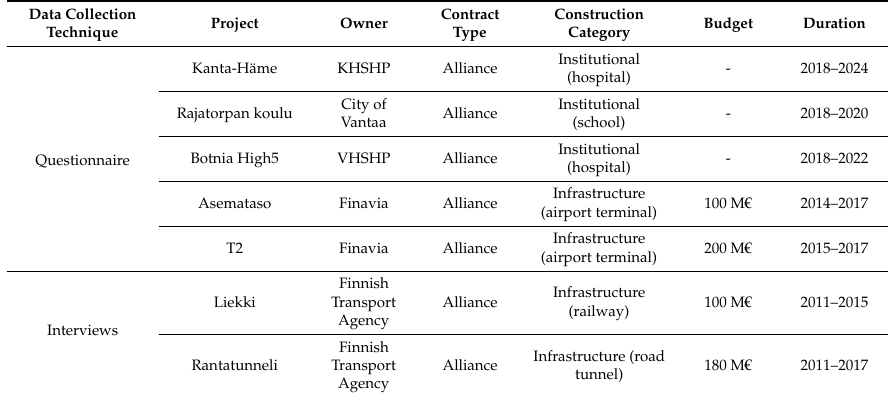
Table 3. Case projects of interviewees and survey